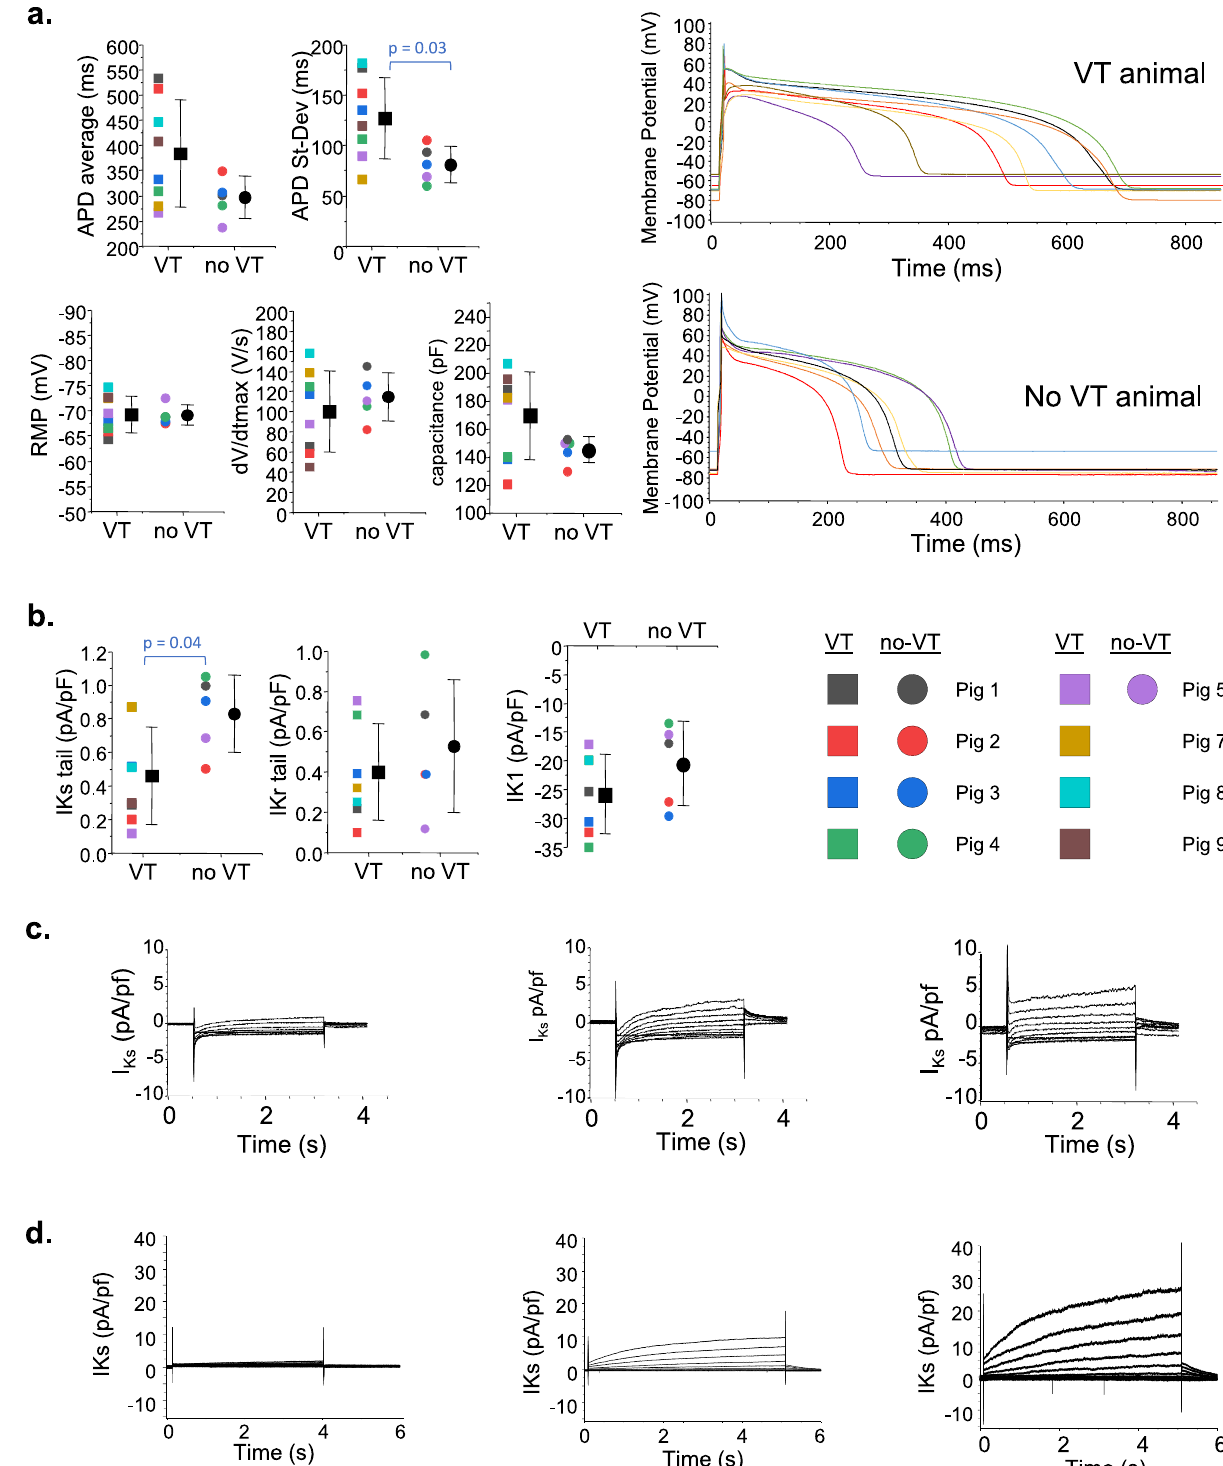
Fig. 5 Patch clamp analysis of cardiac myocytes isolated from the VT region in VT animals and from paired anatomic sites in no-VT animals. ( a ) Action potentials show greater heterogeneity in APD for the VT site but no difference in average APD, RMP, or dV/dt max . The right panel shows APDs recorded from all cells in a single VT animal compared to a single no-VT animal. b Average potassium currents are shown for the three prominent cardiac ventricular repolarizing currents. For the graphs in ( a and b ), n = 8 biologically independent animals in the VT group and fi ve biologically independent animals in the no-VT group. Data are reported as mean ± standard deviation. Data analysis included the Shapiro – Wilk test for normality followed by Student ’ s t test to assess differences. c Variability of I Ks measured from different cells taken within the VT region from a single animal is shown. Some cells had negligible current (left). Other cells had normal current values and morphologies (center), and other cells had increased I Ks with a prominent instantaneous component. This variability was present in 5 of 8 VT animals and 0 of 5 no-VT animals. d I Ks tracings from CHO-I Ks cells transfected with KCNE4 (left), control (center), or KCNE3 (right). Source data are provided as a Source Data fi le. NATURE COMMUNICATIONS| (2022) 13:830 |https://doi.org/10.1038/s41467-022-28418-1|www.nature.com/naturecommunications